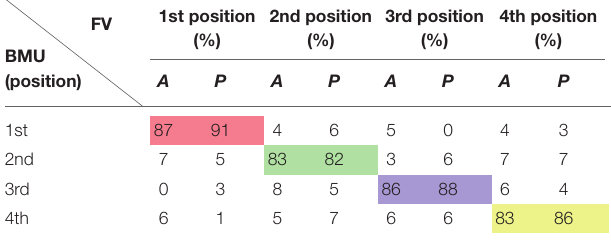
TABLE 2 | Performance measures for SOFMs test data—Separated by forearm flexor (A) and extensor muscles (P) for each thumb grip formation (1st, 2nd, 3rd, and 4th).